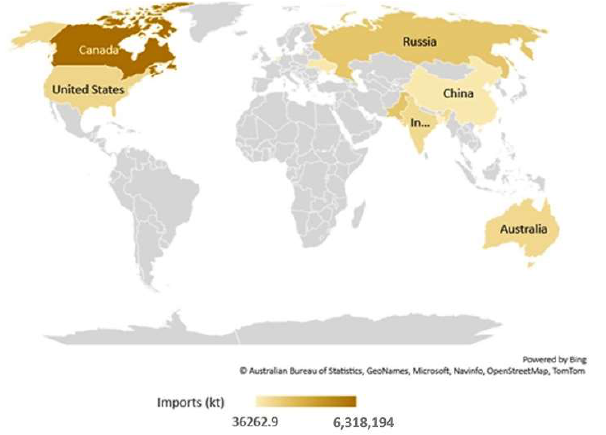
Figure 7. Map of countries exporting crops to Sri Lanka. Darker color means higher.